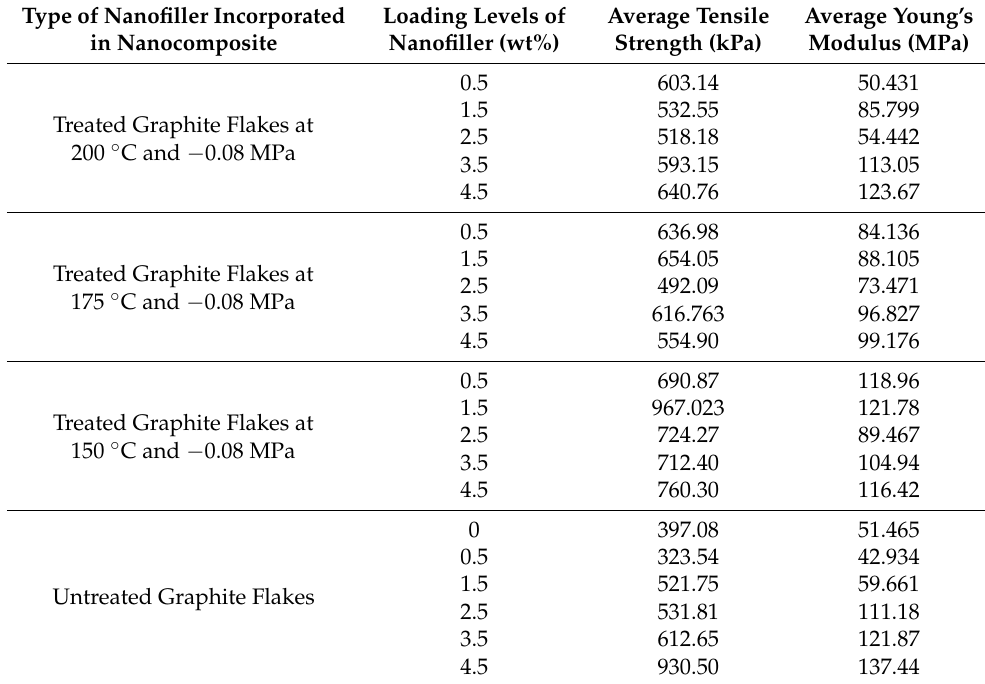
Figure 3. Average Young’s Modulus of All the Nylon 610/Graphite Flake Nanocomposites. Table 1. Mechanical Properties of All the Nylon 610/Graphite Flake